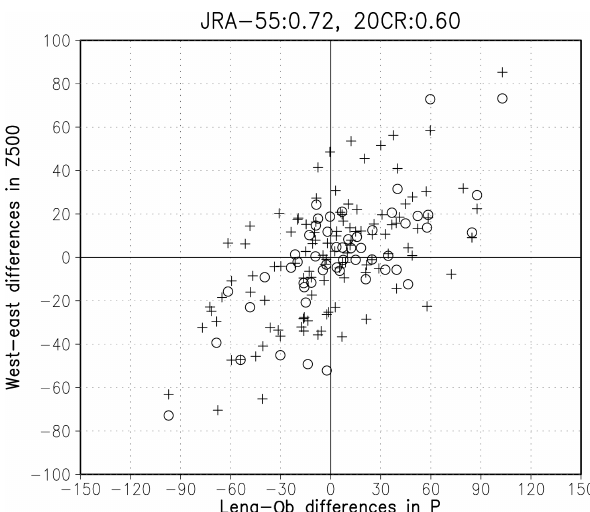
Figure 5. Scatter plot of the summer P differences between the Lena and Ob regions ( (cid:49)P LO ) and the summer Z500 differences be- tween the western and eastern Siberian regions ( (cid:49) Z500 WE ). The ar- eas of (cid:49)P LO ( (cid:49) Z500 WE ) are defined as the green (purple) dashed inset boxes in Fig. 4. The (cid:49) Z500 WE values based on JRA-55 and 20CR are plotted as marked with circles and crosses. Correlation coefficients between (cid:49)P LO and (cid:49) Z500 WE are shown in the upper side of the scatter